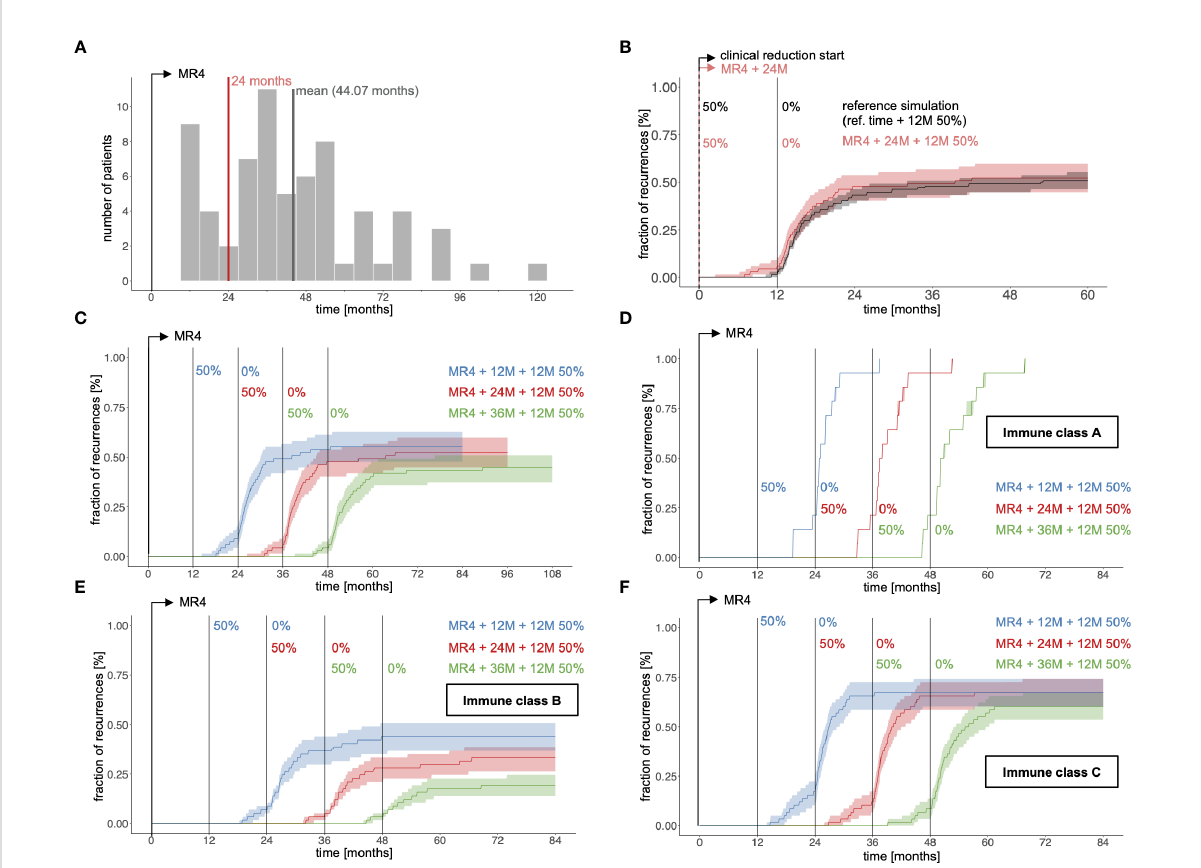
FIGURE 4 (A) Histogram indicating the average time span per patient between reaching MR4 (time = 0) and start of TKI dose reduction for the clinical reference data from the DESTINY trial (grey bars) compared to the MR4+24M+12M50% scenarios in which dose reduction is initiated precisely 24 months after the corresponding fi ts reached MR4 (red line). (B) Fraction of recurrences as a function of time comparing the reference simulation (grey; simulations according to the clinical reference data with respect to time point of dose reduction) and a scenario with a 12 month dose reduction period initiated 24 months after the simulated time courses have reached MR4 (red, indicated as MR4+24M+12M50%). Time = 0 corresponds to the start of TKI dose reduction, either according to the clinical data or of 24 months after reaching MR4. (C)